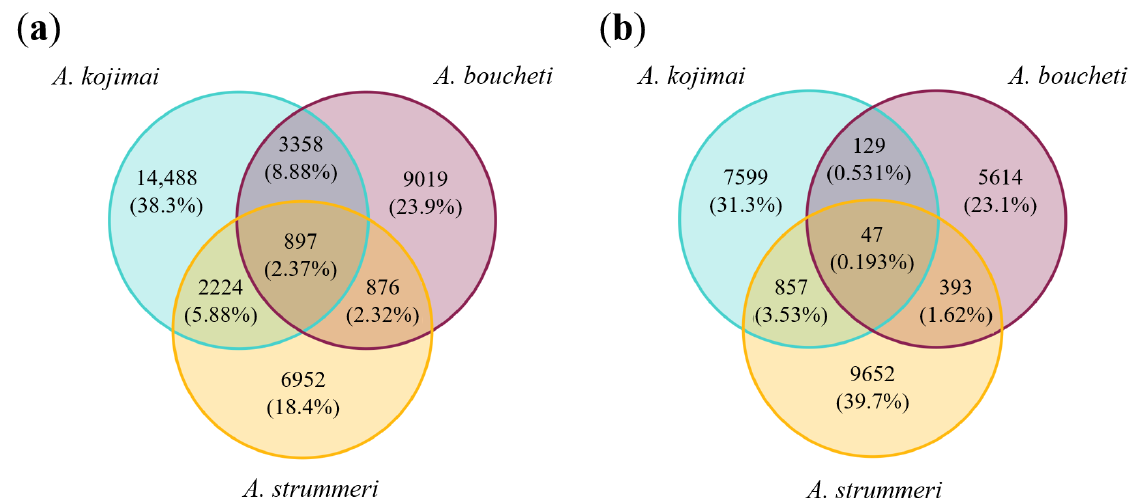
Figure 5. Distribution of polymorphism in the 60,084 SNPs shared by A. kojimai ( n = 250), A. boucheti ( n = 212), and A. strummeri ( n = 36). In panel ( a ), the numbers exclusive to each circle show the num- ber of SNPs that are polymorphic within one species and fixed in the two others (for instance, there are 9019 SNPs that are polymorphic within A. boucheti only). Panel ( b ) shows the same data but considering a SNP as polymorphic only if the allelic frequency of either allele was above 0.0139